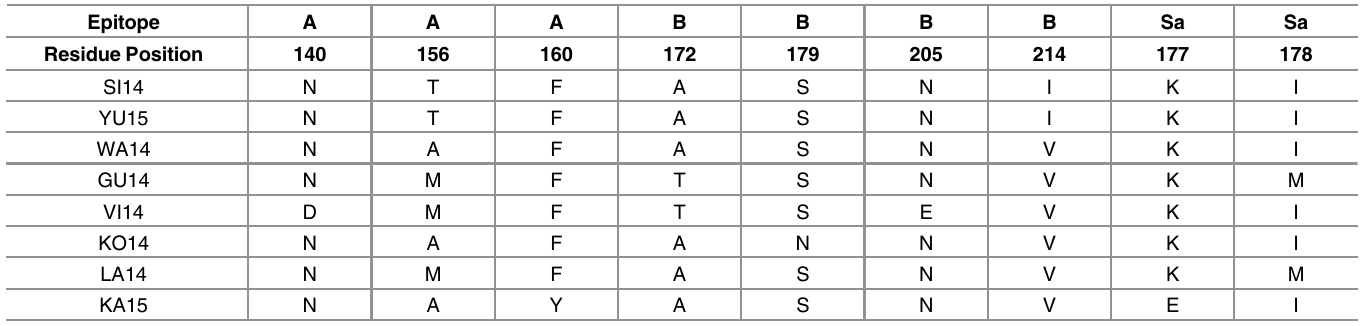
Table 1. Epitope Amino Acid Differences Contributing to PC1 and PC2 position for 2.3.4.4. H5NX Strains.